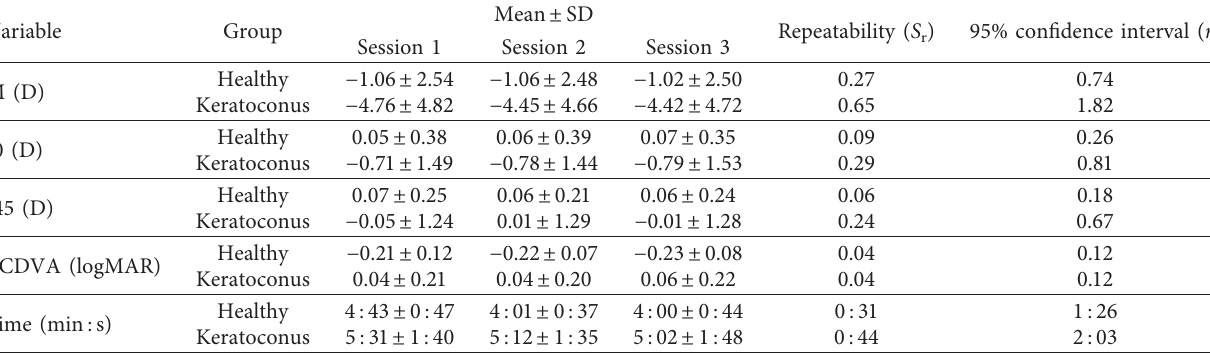
r ) and its 95% confidence interval ( r ) for spherical